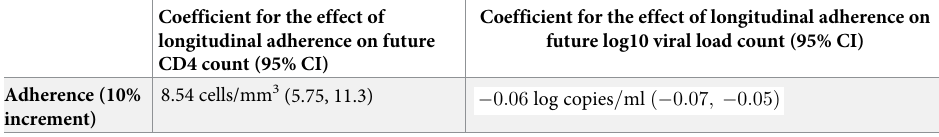
Table 3. Impact of longitudinal adherence on future viral load and CD4 count � .